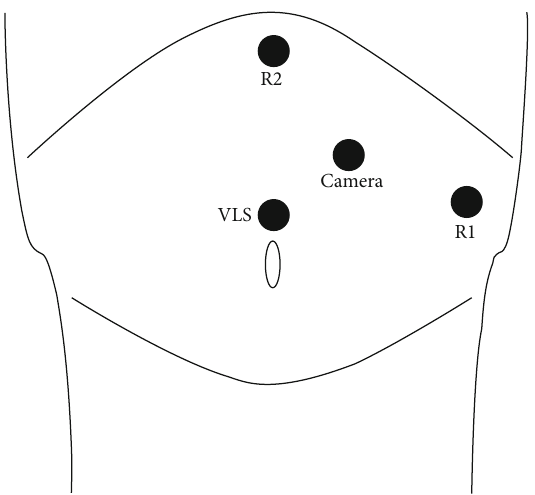
Figure 3: Position of trocars in robotic splenectomy. R1 and R2: robotic arms; VLS: laparoscopic